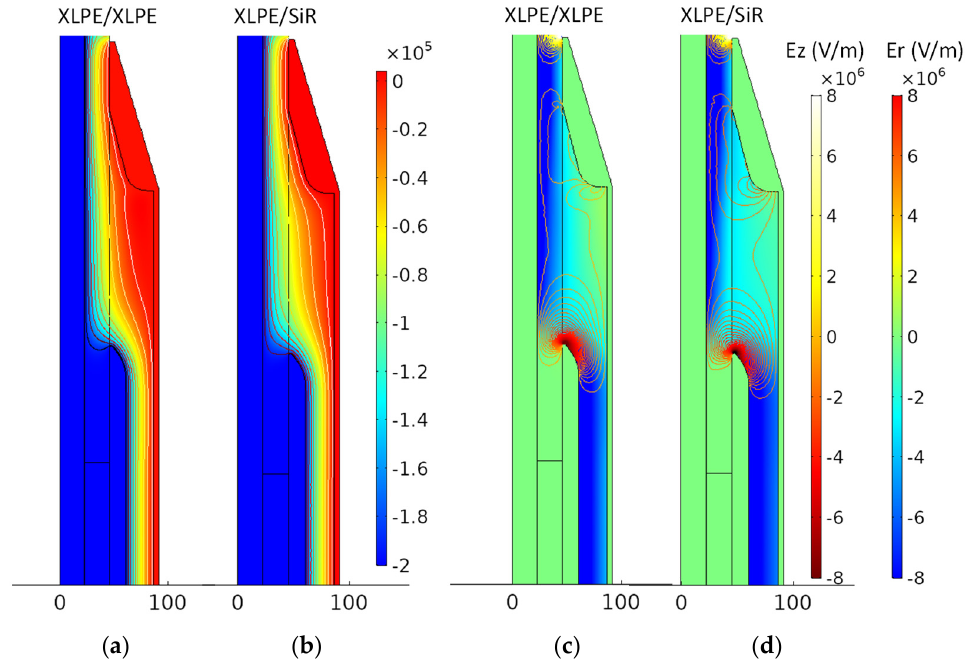
Figure 12. Potential distribution 3’ after polarity reversal to − 200 kV for ( a ) XLPE/XLPE and ( b ) XLPE/SiR joints. Corresponding radial (surface) and tangential (contour lines) field distributions for ( c ) XLPE/XLPE and ( d ) XLPE/SiR joints.